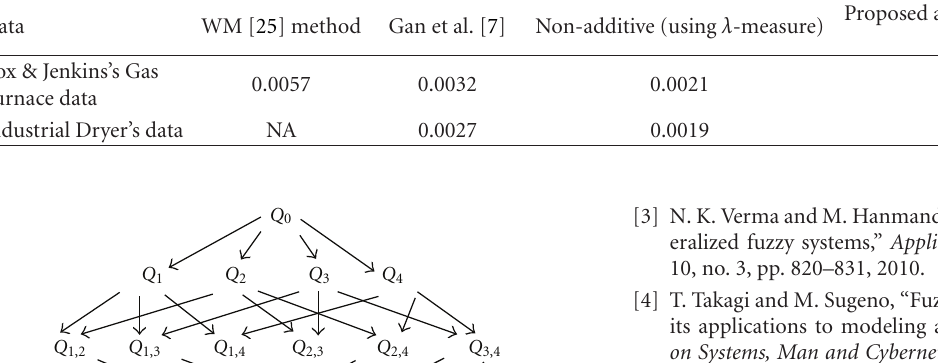
Figure 6: Plot of actual output and model output for training data set (uppermost plot) and plot of actual output and predicted output and the corresponding prediction error for hourly electric load data. Table 19: Comparison of E .